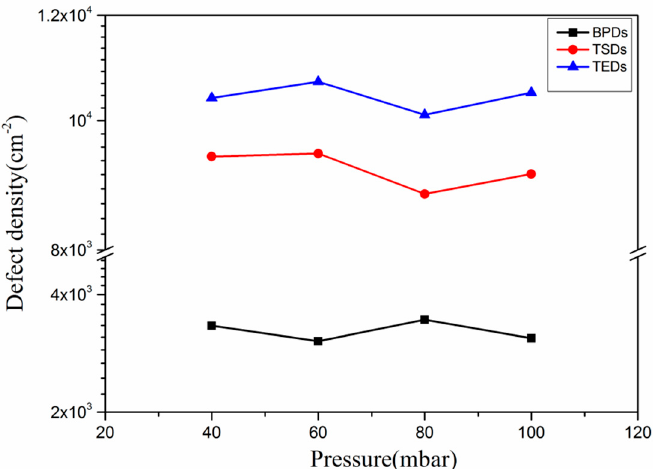
Figure 6. Dislocation densities of epitaxial layers grown at different pressures.